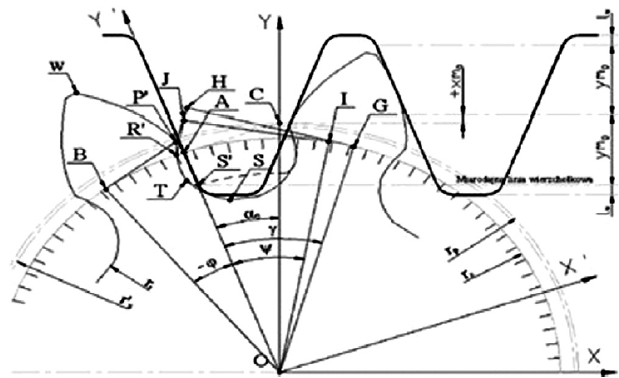
Figure 1. The tooth undercutting by means of a trapezoidal profile rack [5].